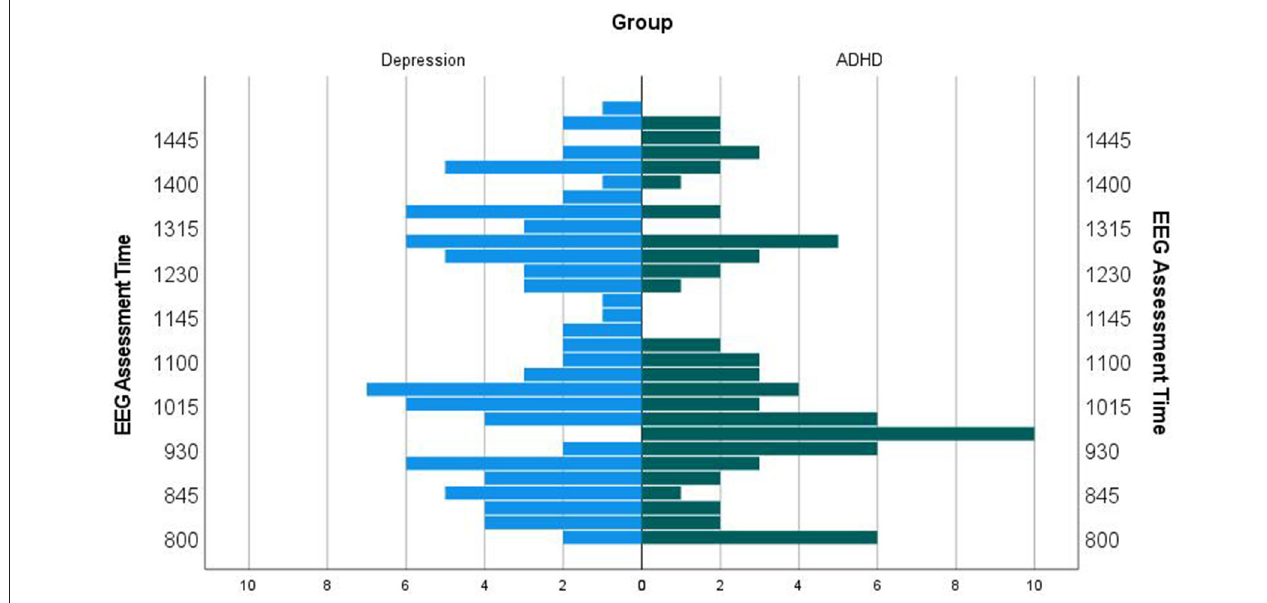
FIGURE 4 | Age of participants. This is the age histogram of the all-eligible participant subsample, N differently distributed; the oldest participants are in the group of children with diagnosis of depression and the youngest participants are mainly in the group of children with ADHD diagnosis. In order to control for possible age effects on the EEG vigilance, we compared the vigilance measures between the diagnostic groups in an age-matched subsample of 19 participants in each group with a 2-month age difference.